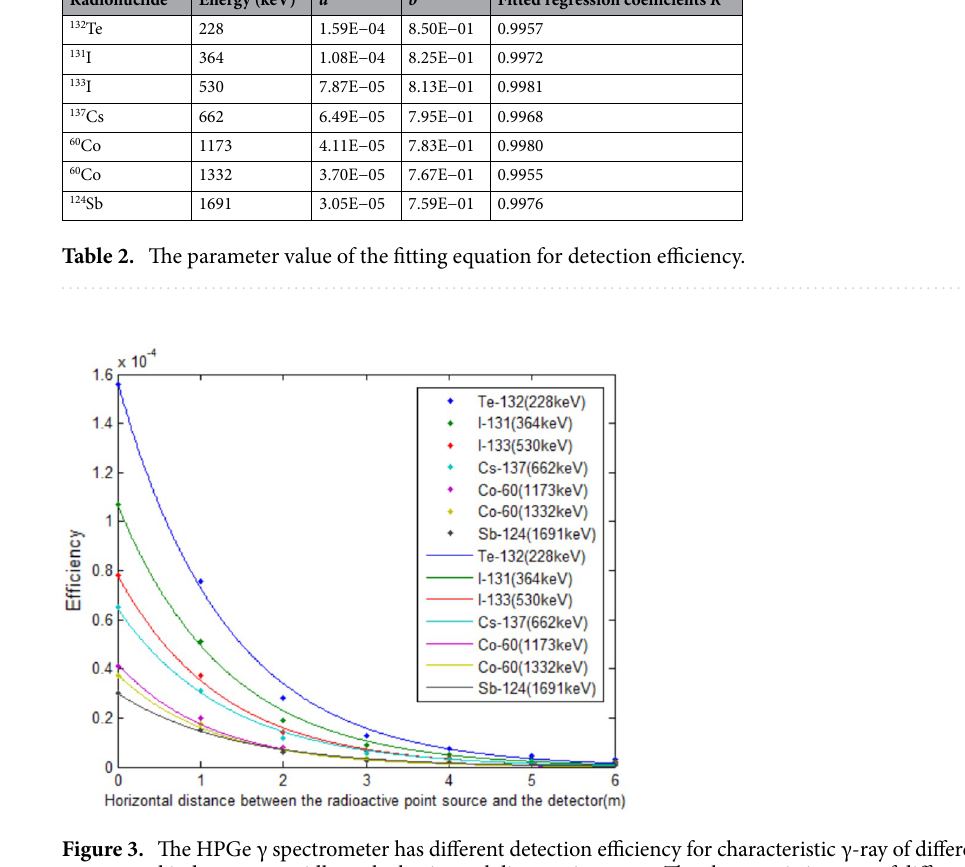
Figure 3. The HPGe γ spectrometer has different detection efficiency for characteristic γ-ray of different energy, and it decreases rapidly as the horizontal distance increases. The characteristic γ-ray of different energy is shown in different colors in the